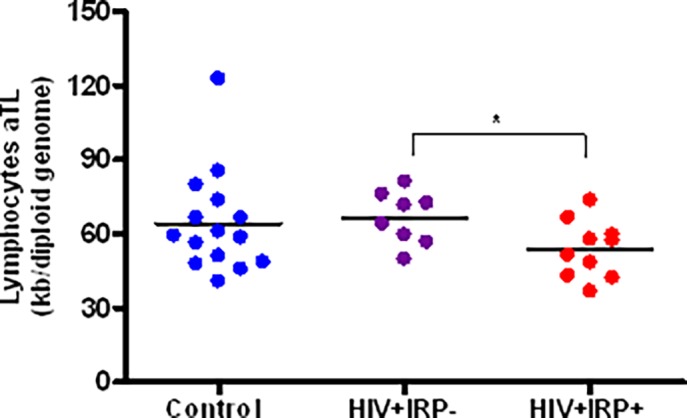
Relationship between the IRP and lymphocyte telomere length.Average telomere length (aTL) was measured in kilobases (kb) per diploid genome. Lymphocyte aTL comparisons were made between uninfected controls (blue), HIV+IRP- (purple) and HIV+IRP+ (red). Statistical significance was determined using the Mann–Whitney U test. *p<0.05, **p<0.01, ***p <0.001.